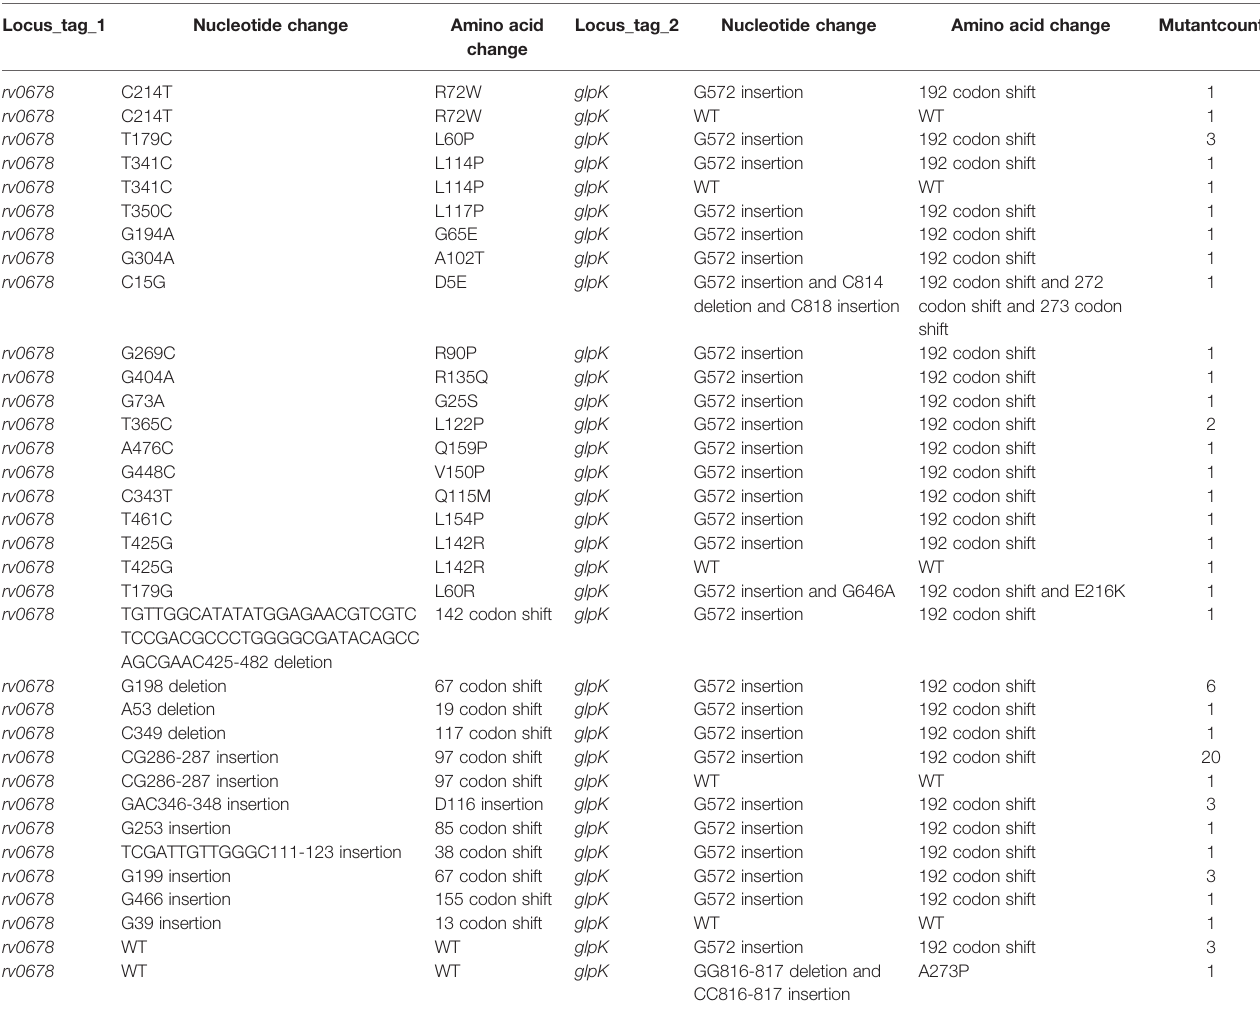
TABLE 2 | Mutation analysis of 67 BDQ-resistant mutants of Mtb by PCR and Sanger analysis.